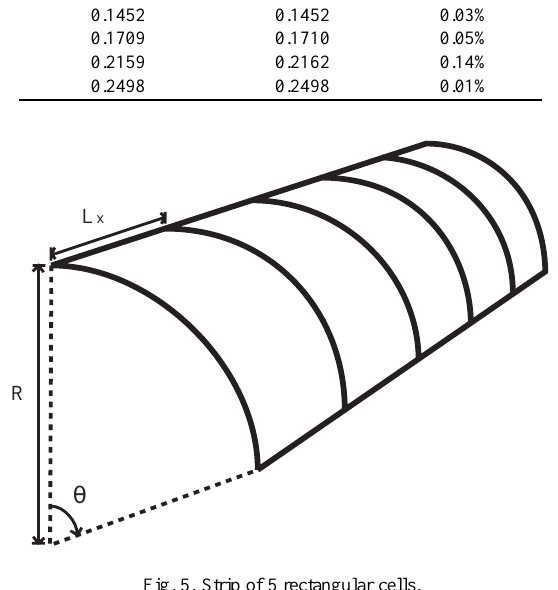
Fig. 5. Strip of 5 rectangular cells.